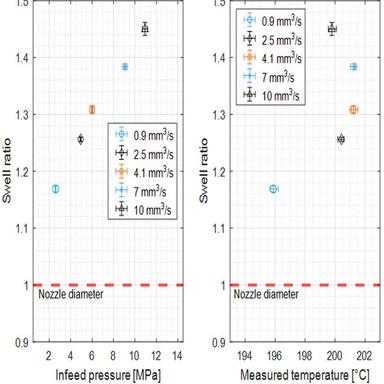
Swell ratio as a function of infeed pressure (left) and as a function of measured temperature (right) for the 0.40 mm nozzle orifice diameter at a hot end temperature setpoint of 200 ◦C. The error bars represent one standard deviation of the swell ratio for the y-axis and one standard deviation of the infeed pressure or measured temperature for the x-axis.